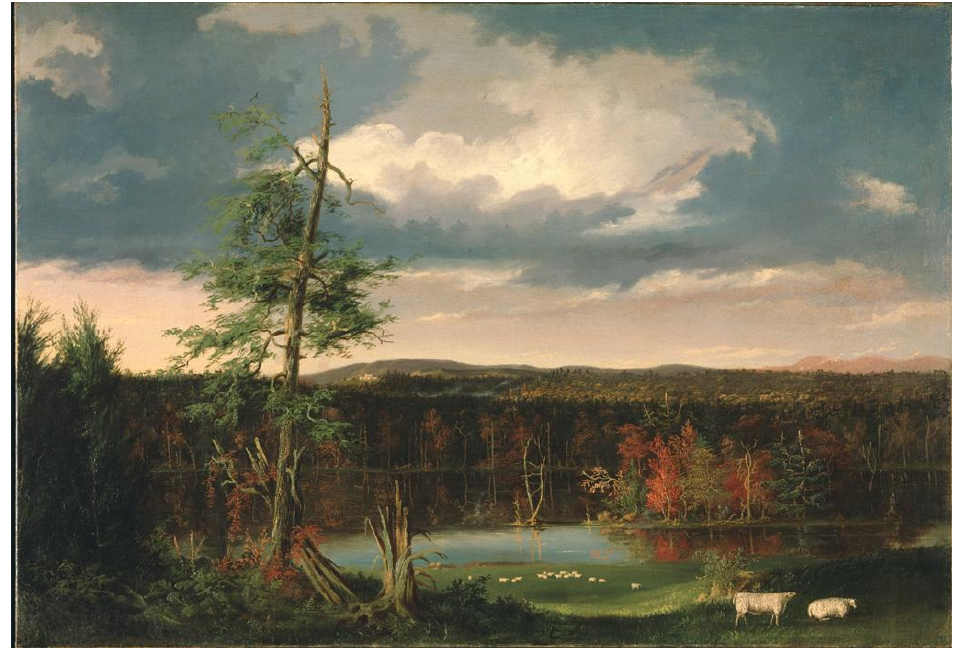
Figure 6. Landscape, the Seat of Mr. Featherstonhaugh in the Distance by Thomas Cole 1826. Oil on canvas. Philadelphia Museum of Art.